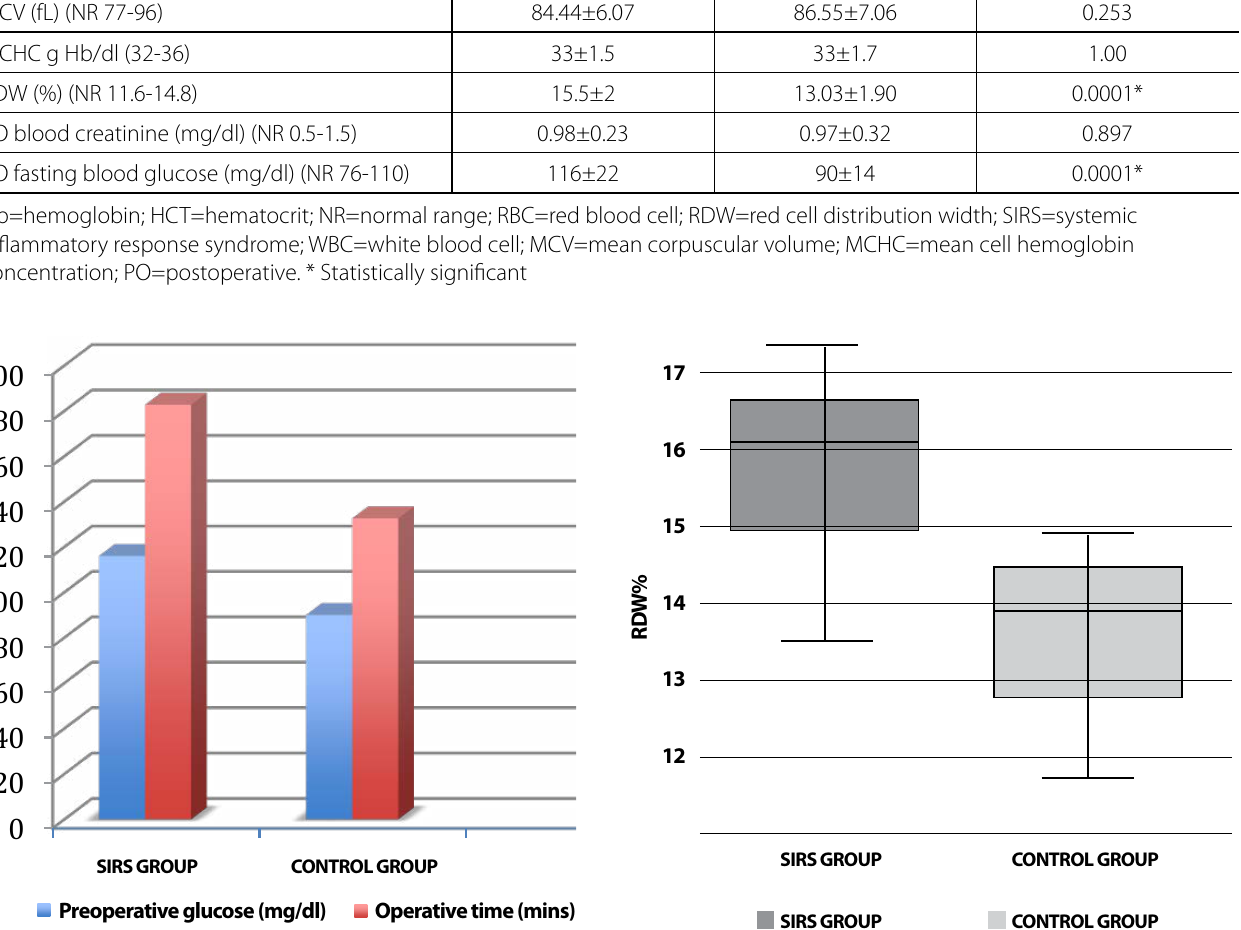
Fig. 2 - Comparison of levels of red cell distribution width in SIRS and control